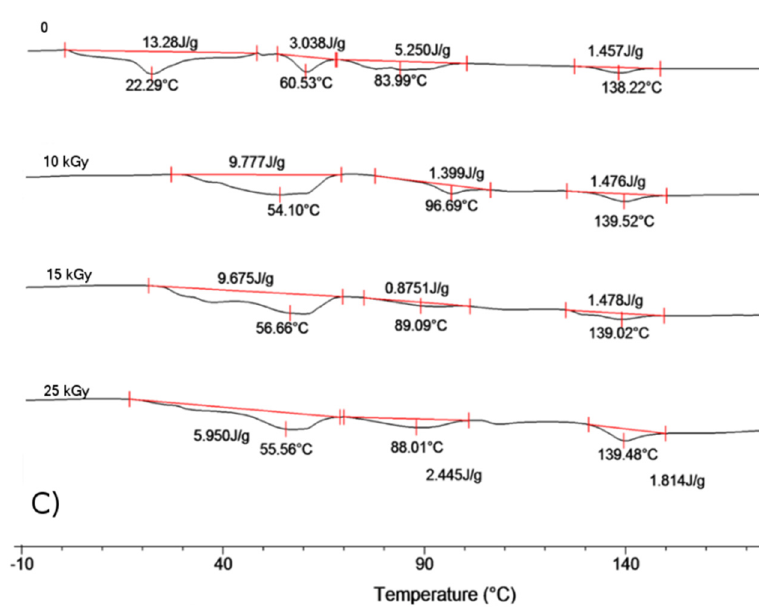
Figure 1. DSC traces for copolymer ( A ) LGT21 C; ( B ) LGT40 C; and ( C ) LTG C. I ‐ heating run at 20 ˝ C/min after γ irradiation with dose: 0 kGy, 10 kGy, 15 kGy, and 25 kGy.